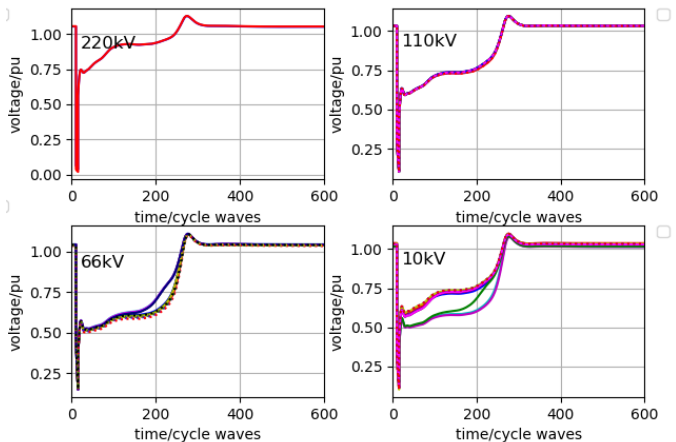
Figure 12. Fault 2 Action 34: Bus positive sequence voltages after SVG compensates 20 Mvar, 50 Mvar, 80 Mvar, 50 Mvar and 60 Mvar, respectively.